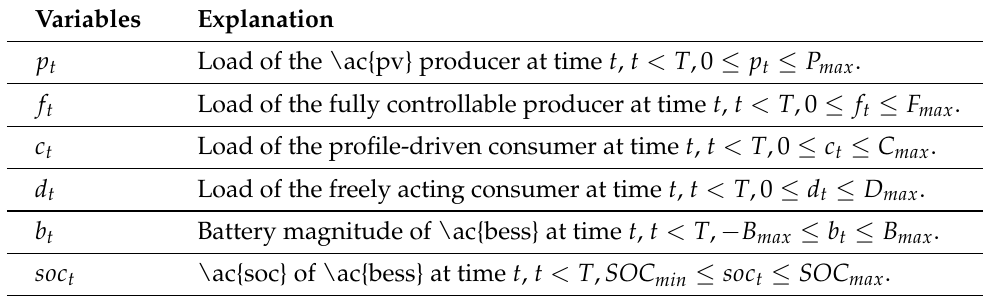
Table 2. Variables mathematical